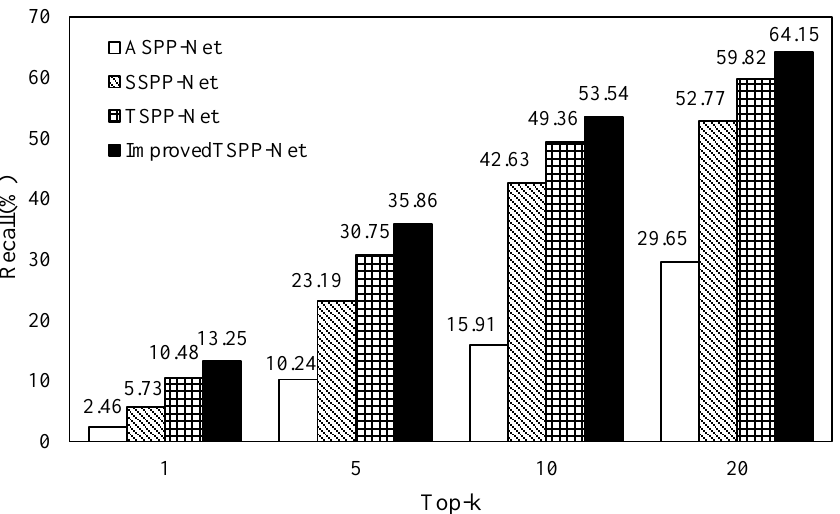
Figure 11. The precision rate of the single-size training.